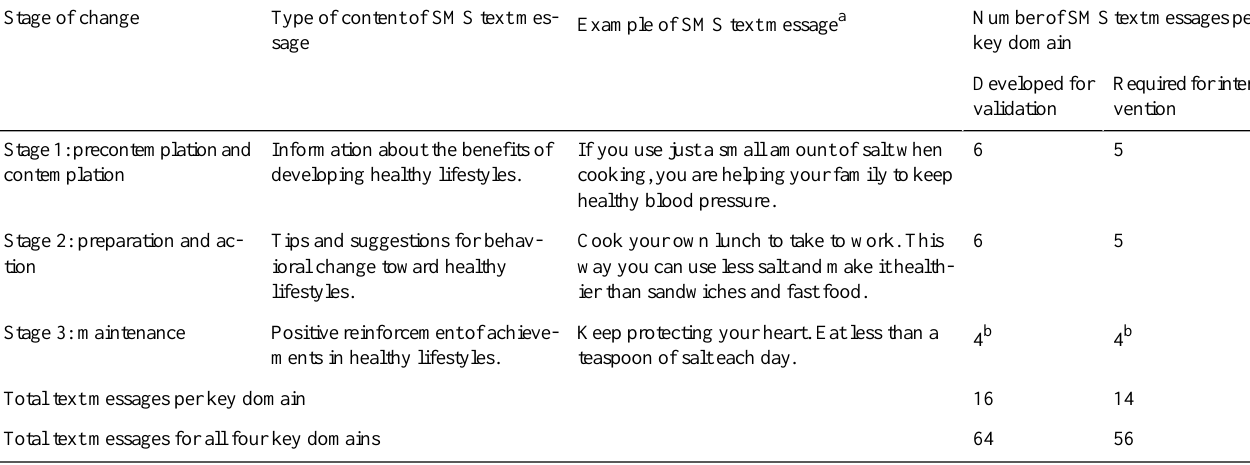
Table 1. Stages of change, type of content, and number of SMS text messages per key domain.